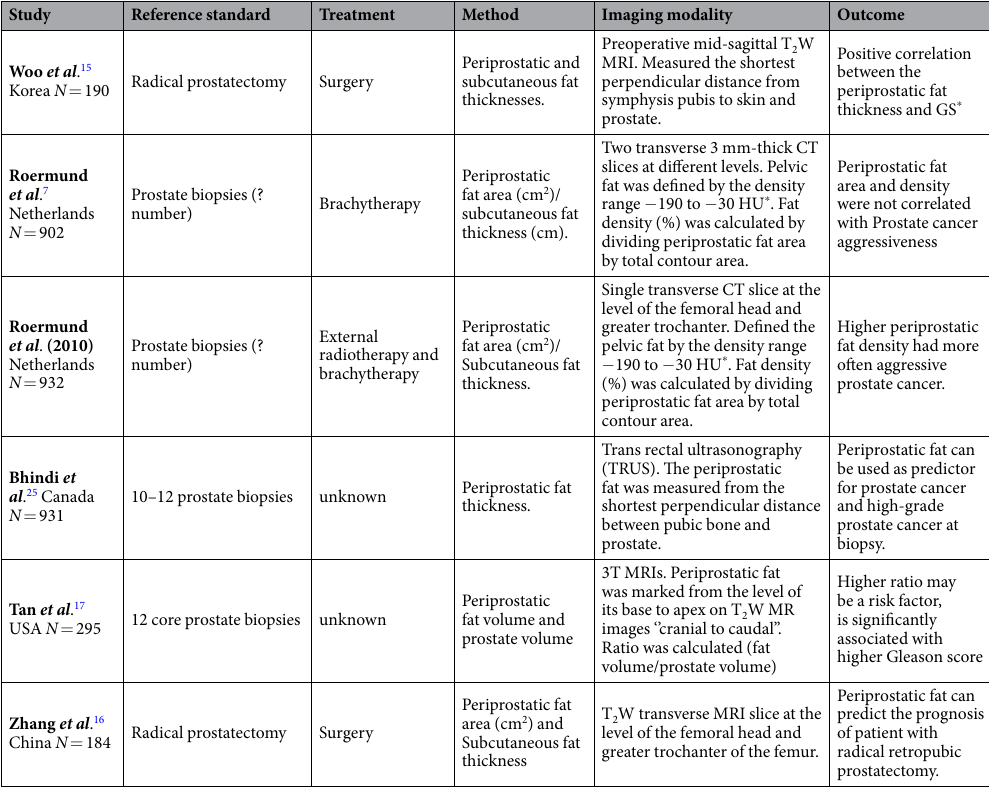
Table 1. Periprostatic fat measurement techniques on imaging and their outcomes in previous studies. * GS = Gleason score. * HU = Hounsfield